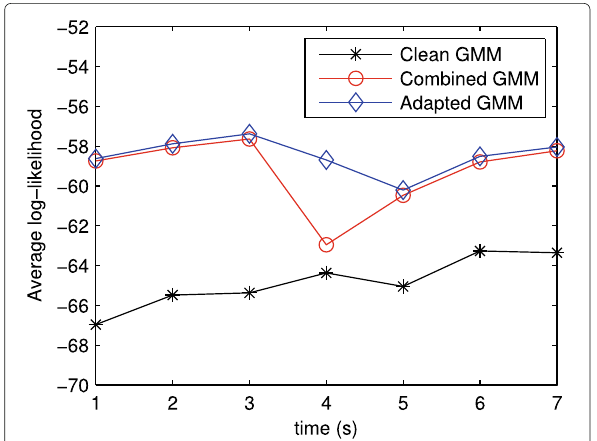
Fig. 2 Average log-likelihoods of the clean, combined, and adapted